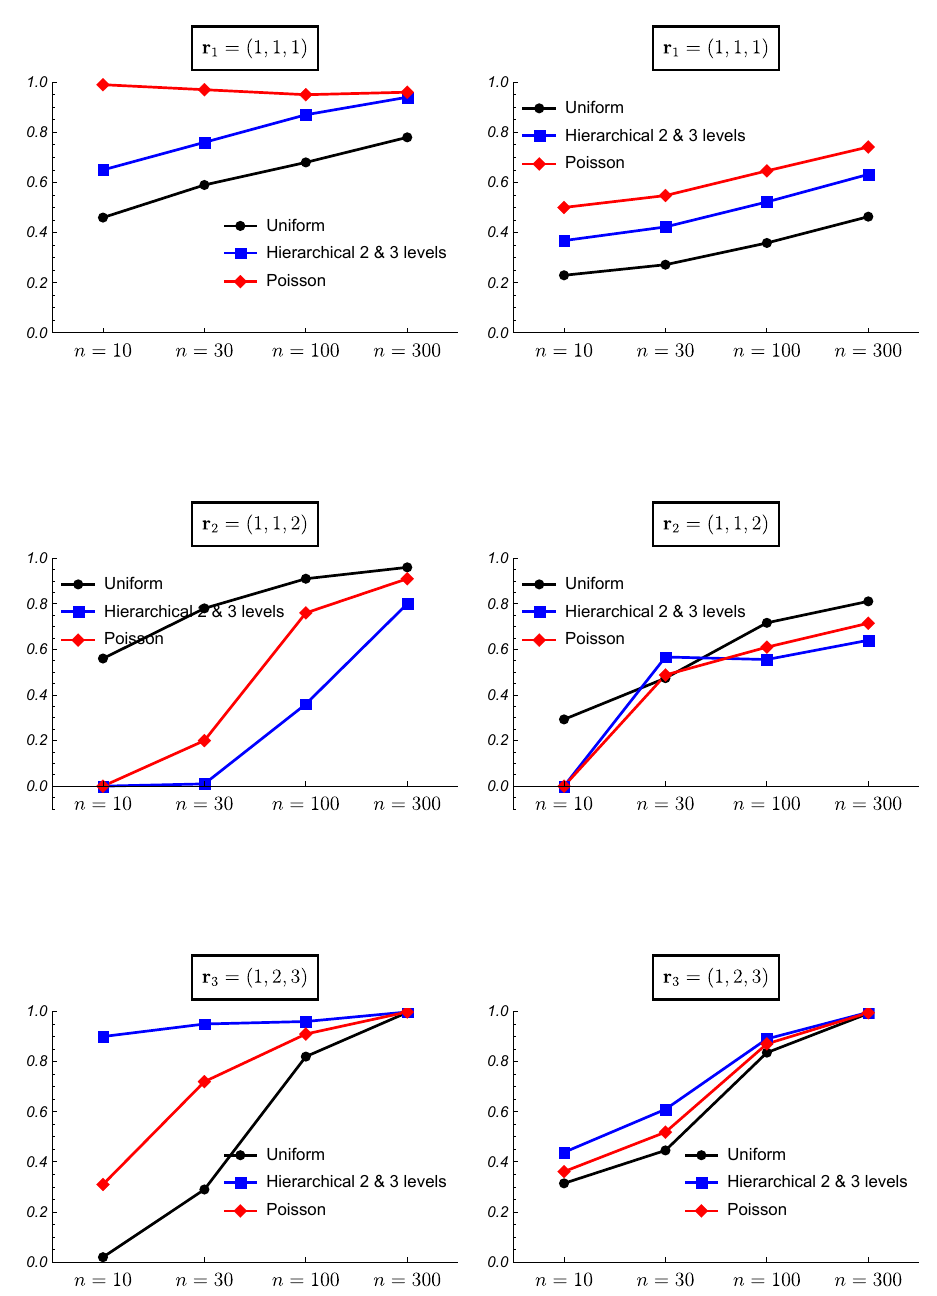
Figure 6. Frequentist validation for the case k = 3 and true partitions r 1 = ( 1,1,1 ) , r 2 = ( 1,1,2 ) and r 3 = ( 1,2,3 ) . ( Left column ) proportion of times the true partition is found as the most probable. ( Right column ) mean of the posterior probability for the true partition when it is found as the most